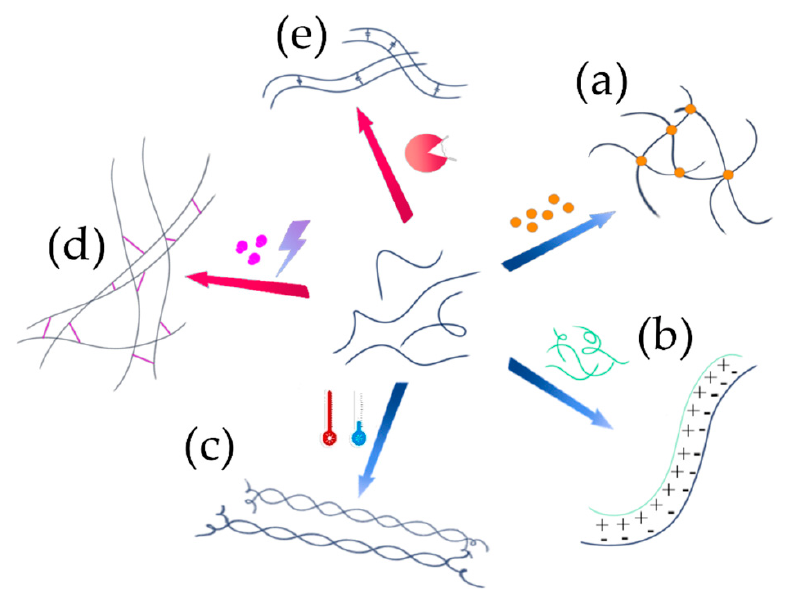
Figure 4. Graphical representation of hydrogel formation process through physical (blue arrows) or chemical (red arrows) interactions among macromolecular chains. ( a ) Ionic crosslinking, ( b ) polyelectrolyte complex (PEC) formation, ( c ) thermoresponsive gelling process, ( d ) photoactivated crosslinking, and ( e ) enzymatic crosslinking.